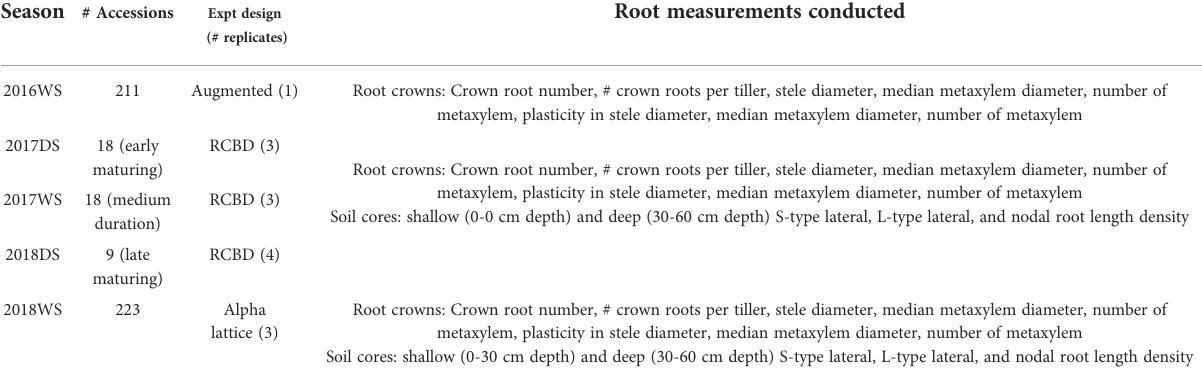
TABLE 1 List of experiments and measurements conducted in this study. Season #